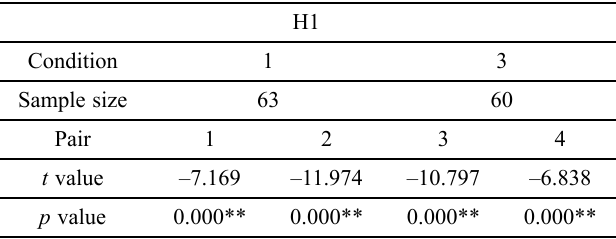
Table 2. Results for hypothesis H1